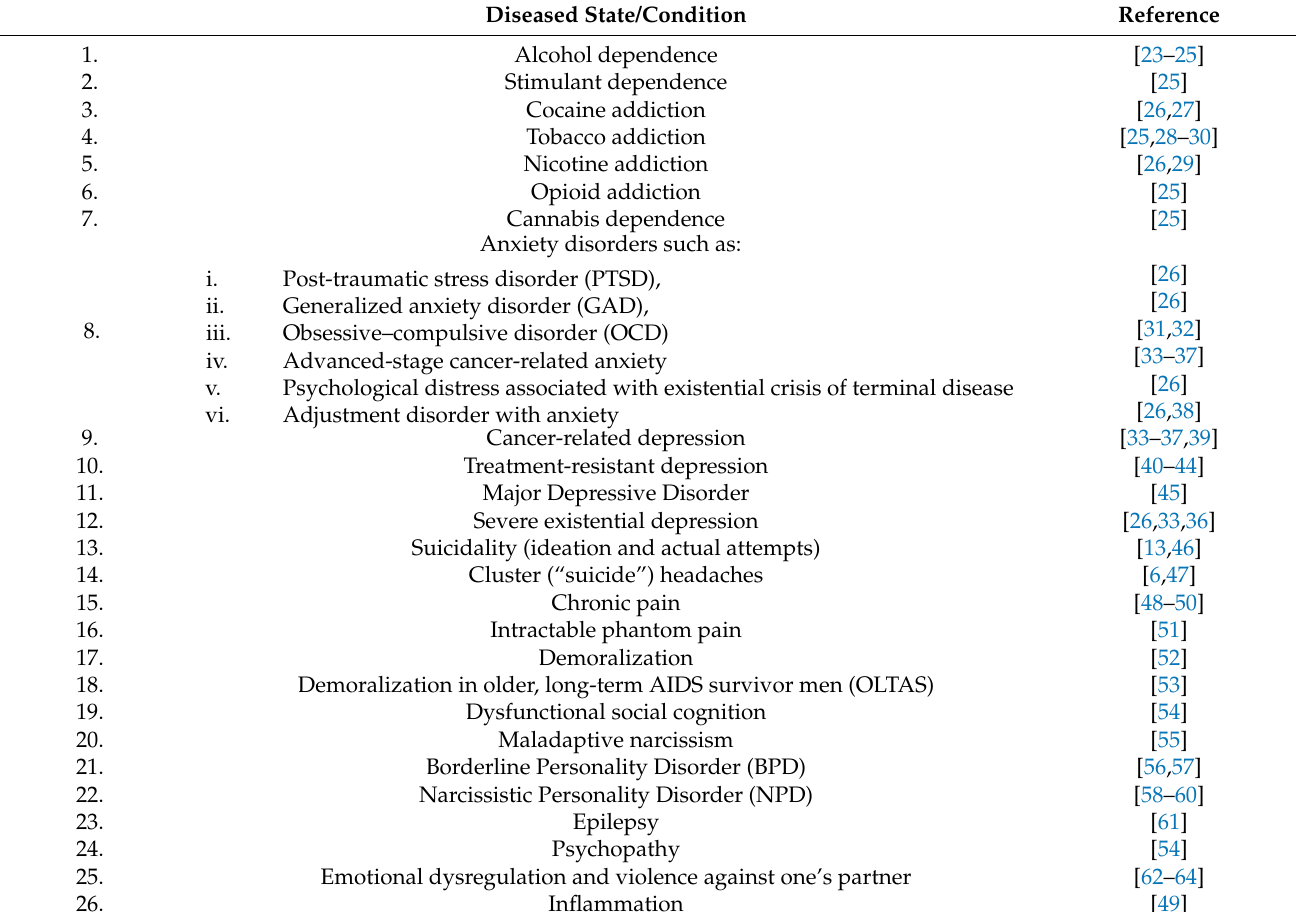
Table 1. The potential therapeutic window of psilocybin-assisted therapy, that is, diseased states in which psilocybin-assisted therapy is being